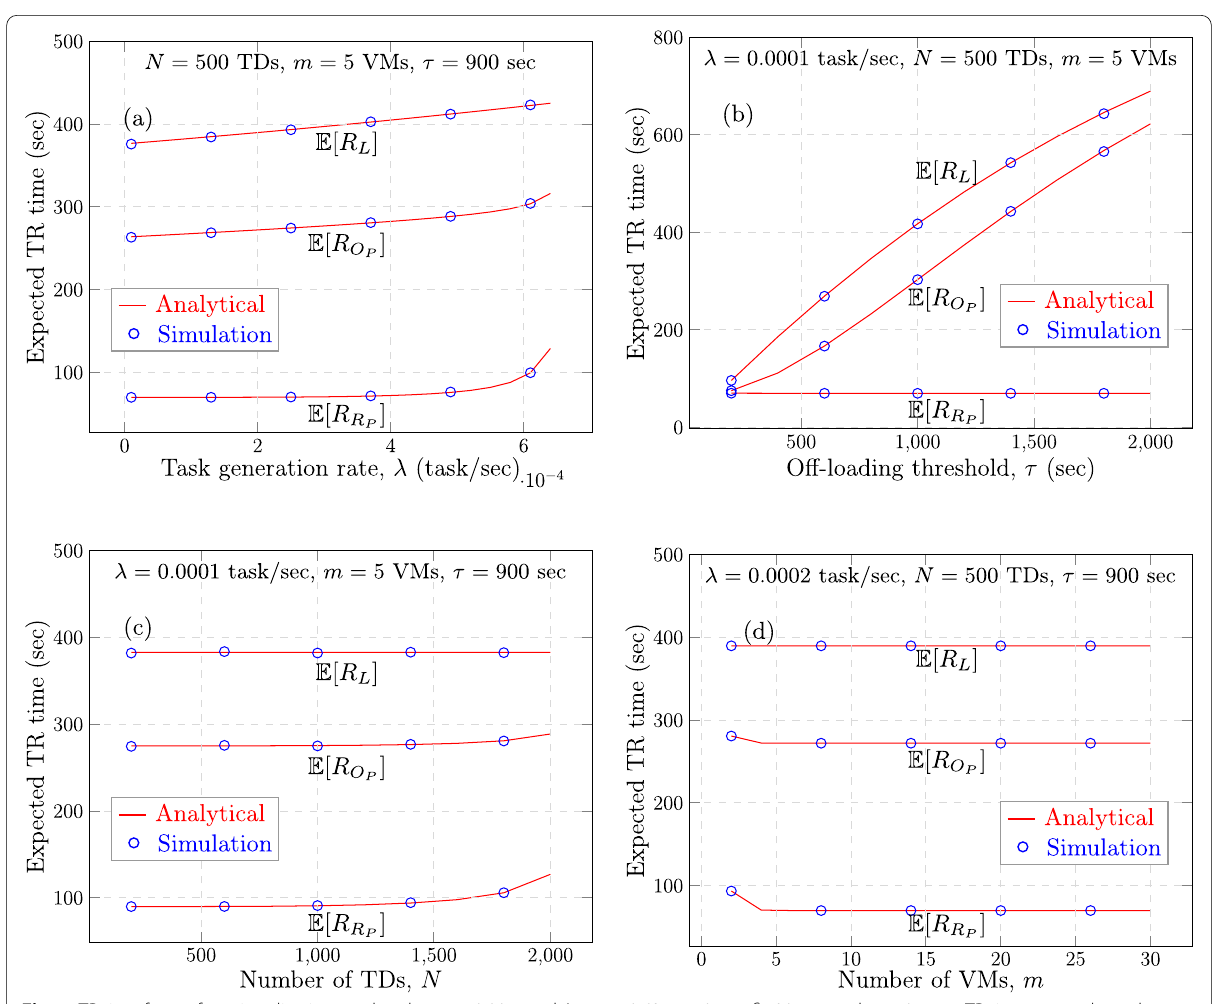
Fig. 4 TR time for perfect virtualization mode, where μ inter‑generation λ . b TR time versus the off‑loading threshold τ . c TR time versus the number of TDs N . d TR time versus the number of VMs